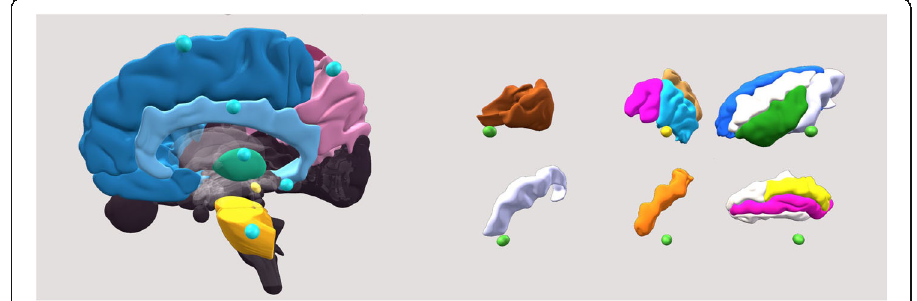
Fig. 2 Graphical elements of the neuroanatomy game, showing a cross section of a whole brain (left) and several brain parts it consists of (right). Small spheres indicate points of interaction where connections can be drawn between elements which belong